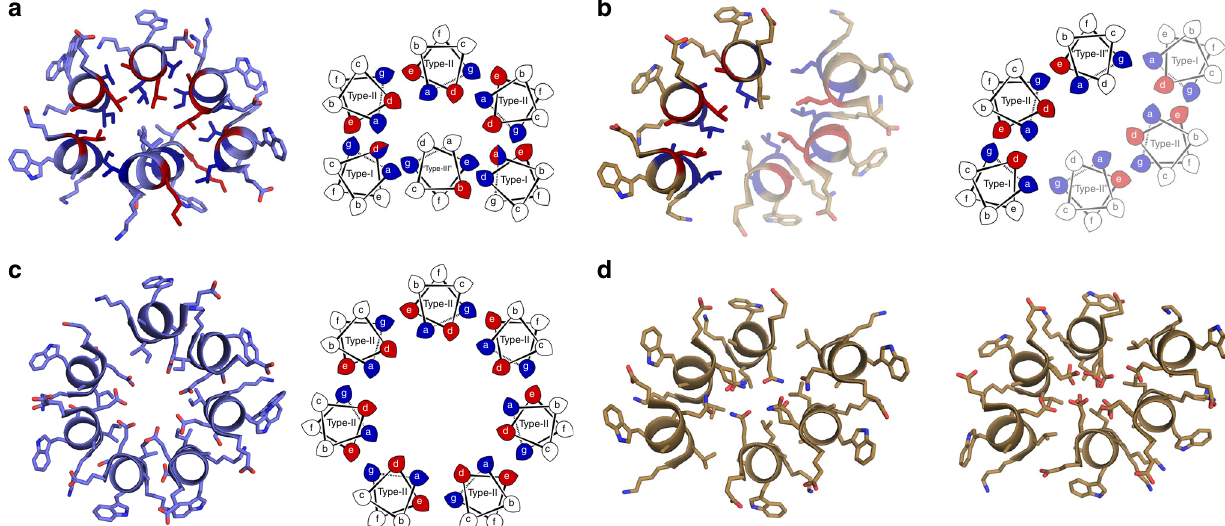
Fig. 4 Coiled-coil bundles containing β L or LL cores. a CC-Type2-IL-Sg. b CC-Type2-LL. c CC-Type2-IL-Sg-L17E. d (left) CC-Type2-LL-L17Q. d (right) CC-Type2-LL-L17E. Left-hand side (and both sides for d ), single-heptad slices through X-ray crystal structures. Right-hand side (except panel d ), helical- wheel representation with knob residues coloured red for parallel-like packing and blue for perpendicular-like packing. Semi-transparent helices are symmetry related to the opaque